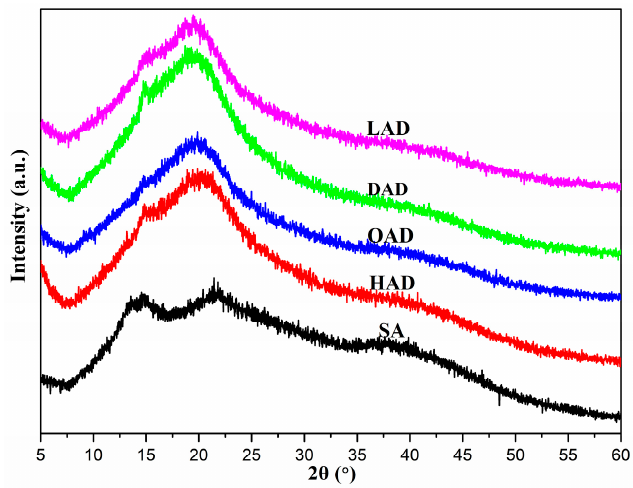
Figure 3. X-ray diffractograms of SA, HAD, OAD, DAD, and LAD.